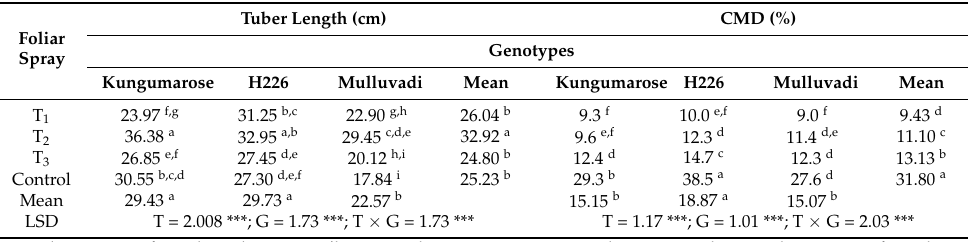
Table 5. Interaction of time of combined nutrient/biocontrol agent mixture spray and genotypes on tuber length (cm), and CMD (%) in cassava ( n = 10). Means followed by the same letter are not statistically significant at p < 0.05.